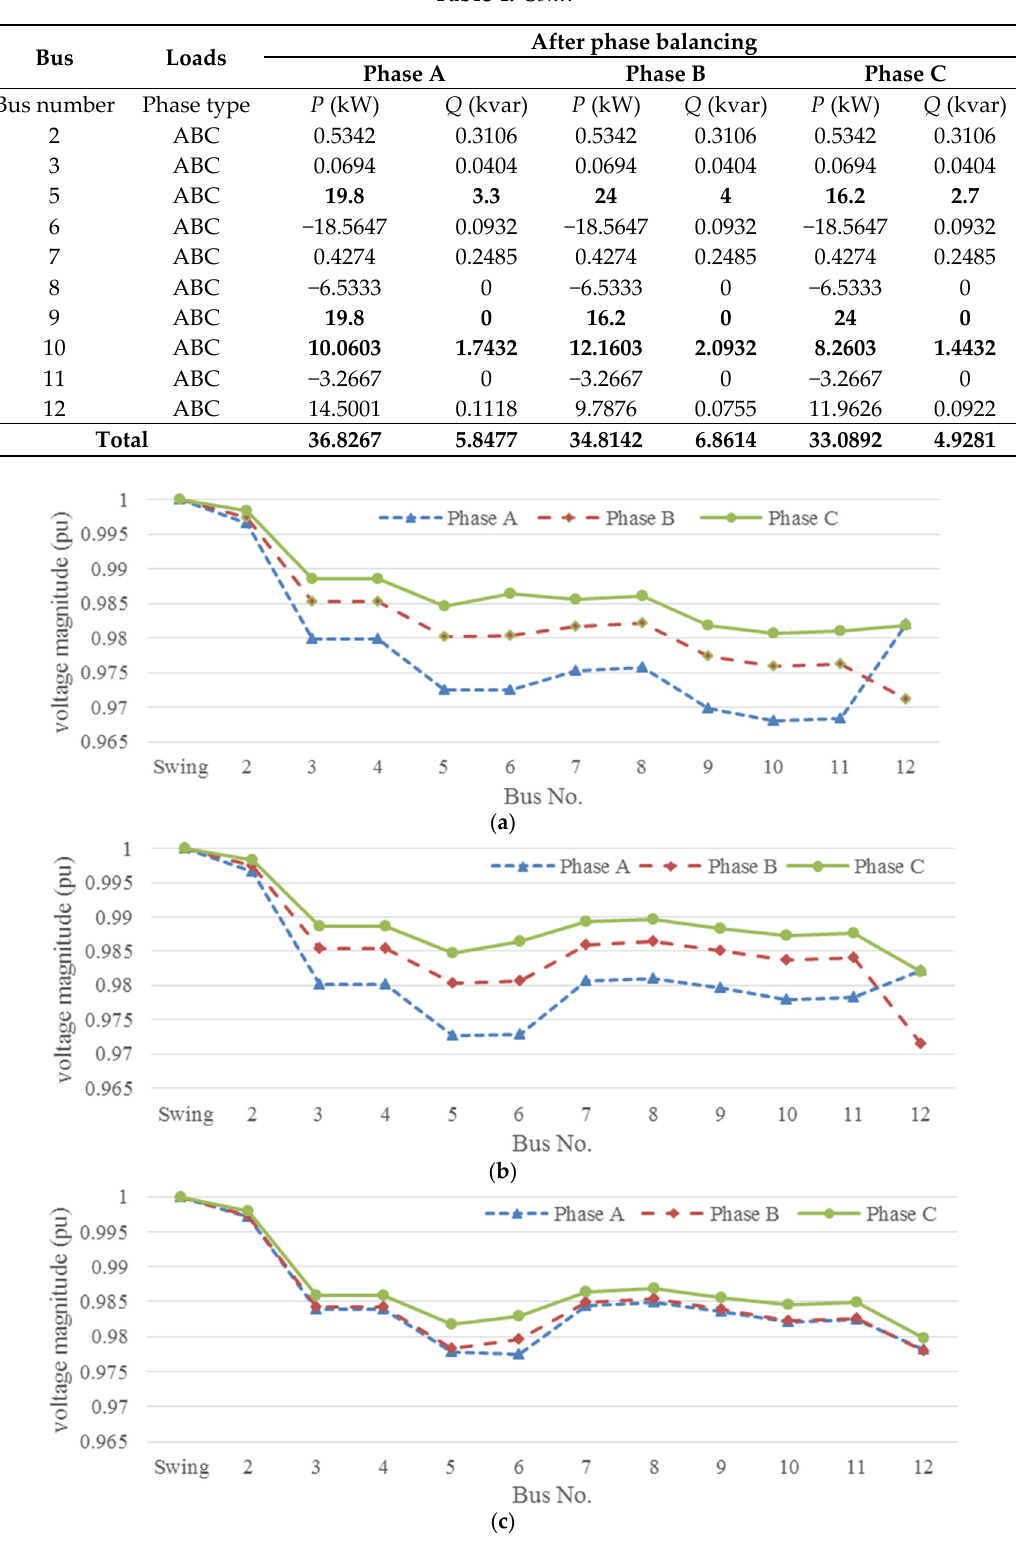
Figure 11. Simulation result of the bus voltage of a weekday in summer of the INER microgrid: ( a ) before optimization; ( b ) after first stage; and ( c ) after second